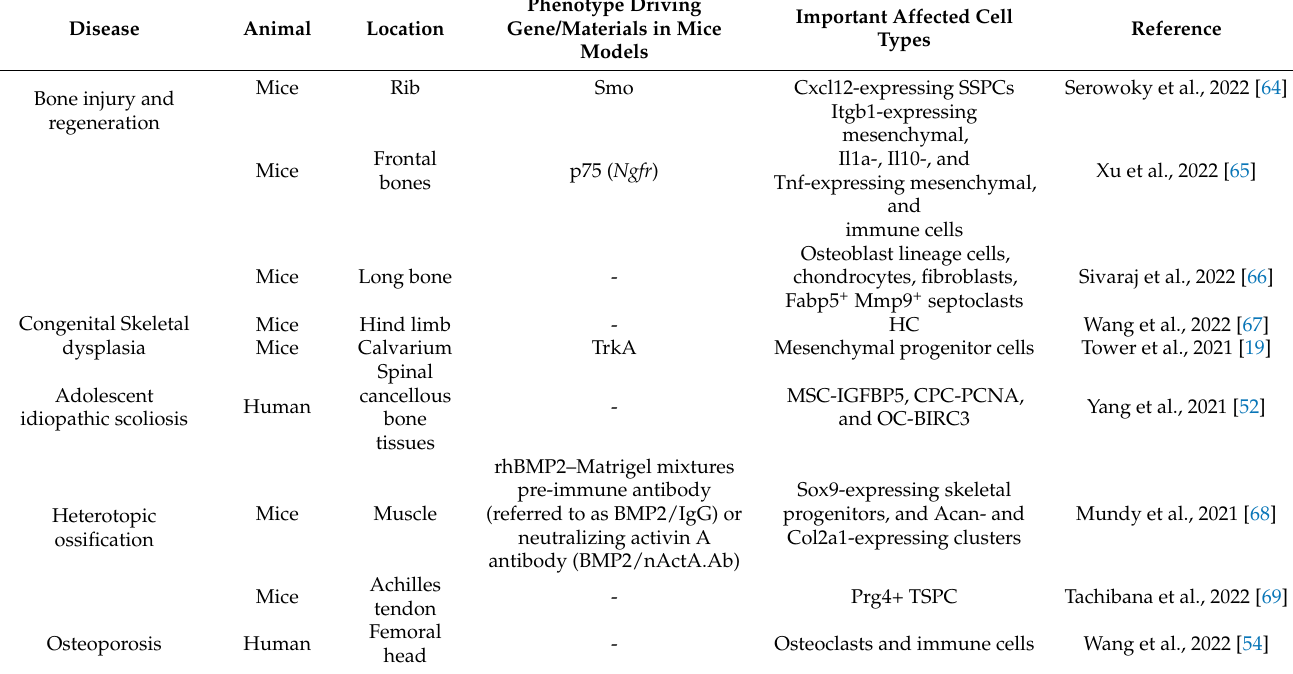
Table 2. Application of single-cell and spatial omics to decode bone-related diseases.